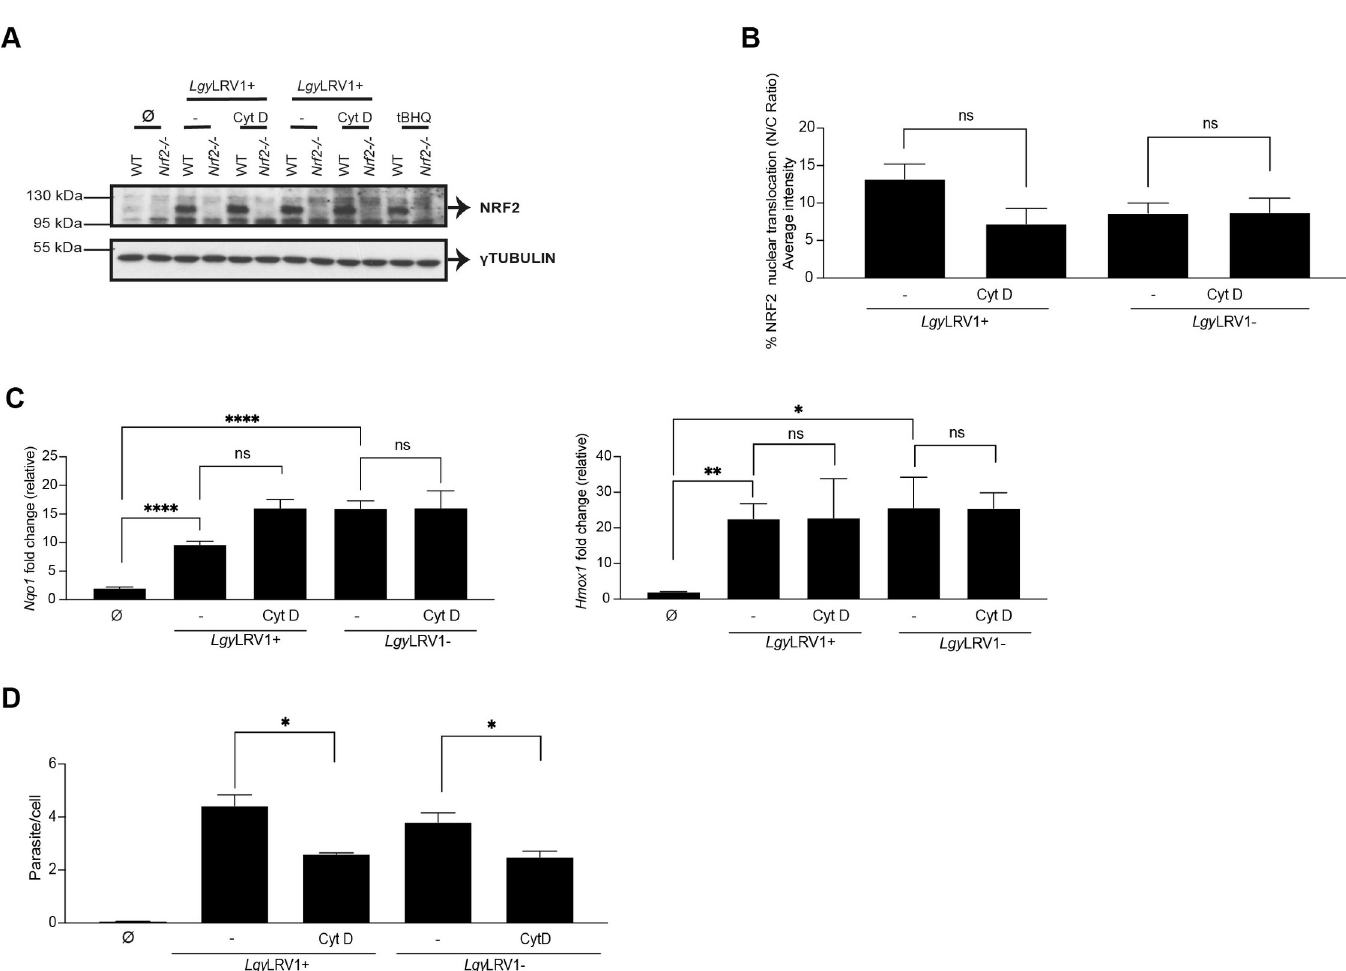
Fig 5. Decreasing phagocytosis did not block NRF2 activation in Lgy infection. A-D) WT, Nox2 -/- or Nrf2 -/- cells were pretreated with DMSO or Cytochalasin D (Cyt D, 40 μ M) for 1 hr and infected with Lgy LRV1+ or Lgy LRV1- parasites or stimulated with tBHQ (10 μ M), or medium-treated ( Ø ). A) Cells lysates were immunoblotted with anti-NRF2 and anti- γ TUBULIN antibodies. B) WT cells were stained with NRF2 and DAPI for assessing NRF2 nuclear translocation expressed as nucleus/cytoplasm (N/C) ratio at 8 hrs at 40x using a high-content microscope. NRF2 nuclear translocation was quantified using MetaXpress software and normalized to non-infected ( Ø ). C) Nqo1 and Hmox1 relative RNA levels were measured by RT-qPCR at 8 hrs post-infection and normalized to L32 housekeeping gene. D) Intracellular parasite load was quantified by DAPI staining at 8 hrs at 40x using a high-content microscope. Parasite load was quantified using MetaXpress software. Representative blots are shown from three independent experiments. The graphs show pooled data expressed as mean ± SEM from two independent experiments. Unpaired Student’s t test was used to measure statistical significance. Not significant (ns), � p < 0.05, �� p < 0.01 and ���� p < 0.0001. See also S5